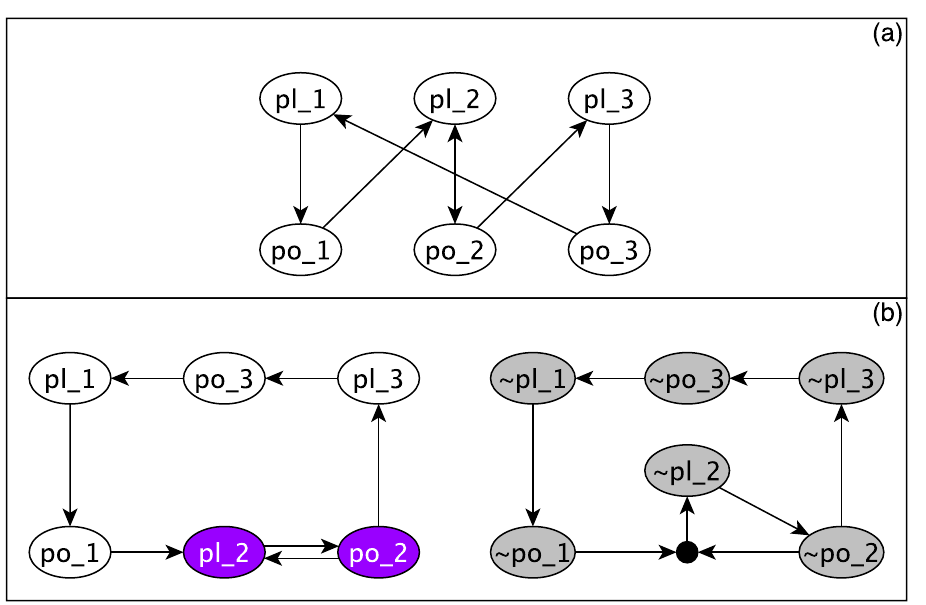
Figure 5. Histogram plots illustrating the average percentage of the damage caused in an established community after the extinction of species. This analysis is performed over 1000 networks with the size of 70 nodes (30 nodes representing plant species and 40 nodes representing pollinator species). The original extinctions are excluded from the damage percentages. The left plot shows the average damage percentage caused to the maximal richness community by the extinction of 2 species that are a subset of the 4-node driver set of an inactive stable motif or motif group plus 2 randomly selected non-driver species. The right plot shows the damage percentage caused to the maximal richness community by the extinction of 4-node driver sets of the same inactive stable motifs and motif groups. Each time the driver set of one stable motif or motif group was the subject of extinction and we calculated the average damage percentage over all data points collected for each network. 295 networks qualified for this analysis.